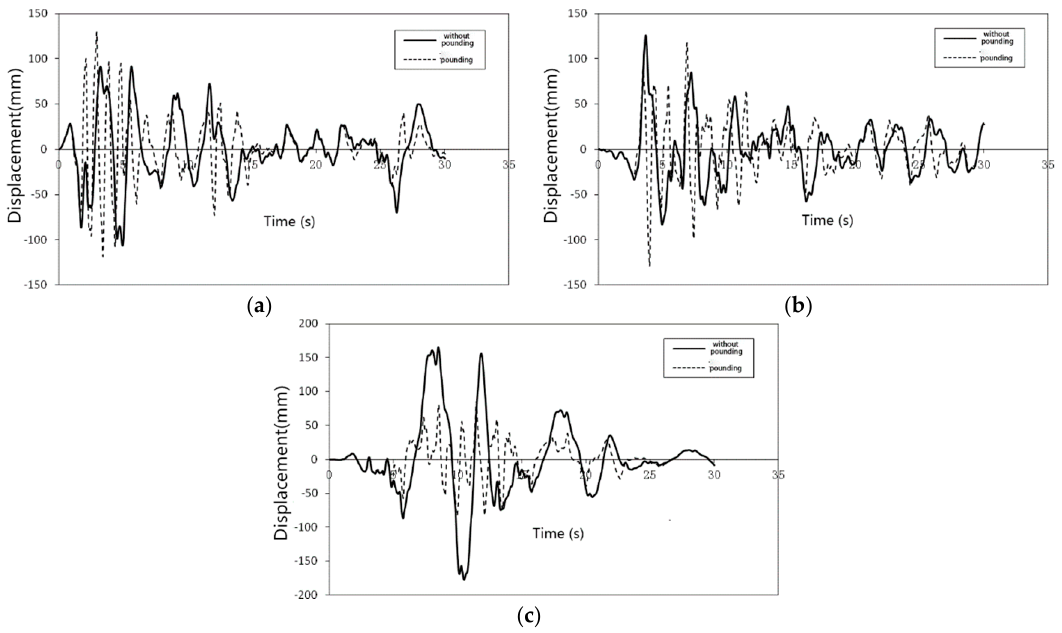
Figure 21. Structural displacement under different earthquakes (model B). ( a ) El Centro earthquake; ( b ) Taft earthquake; and, ( c ) Artificial excitation. Table 8. Maximum structural displacements for model A.